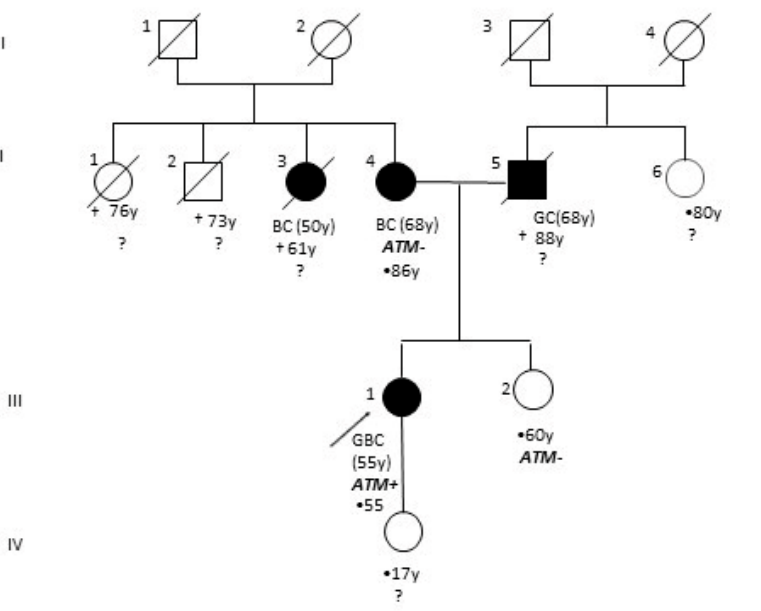
Figure 1. Patient’s family pedigree with four generations depicted. Black circles and squares indicate individuals affected by cancer. The proband is indicated with an arrow. GC: gastric cancer, BC: breast cancer, GBC: gallbladder cancer, y: years at diagnosis of cancer, †: age of death, • : current age, ataxia telangiectasia mutated (ATM)+: ATM mutated, ATM − : negative on ATM screening, ?: untested for ATM mutations.